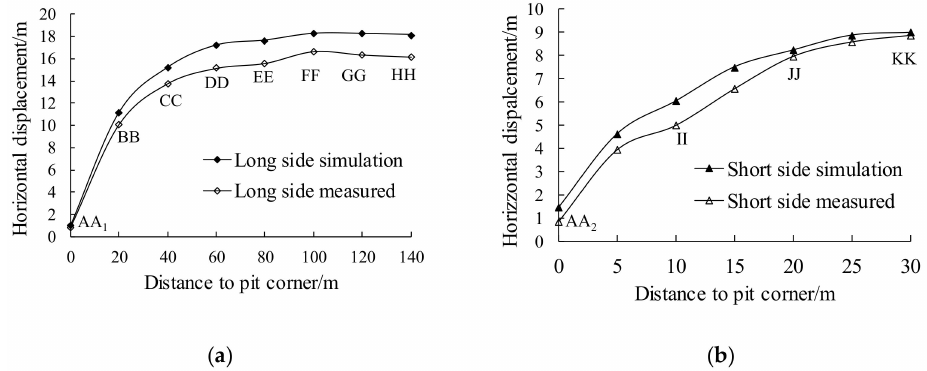
Figure 14. Horizontal displacement of piles top: ( a ) HH section of the long side, ( b ) KK section of the short side.